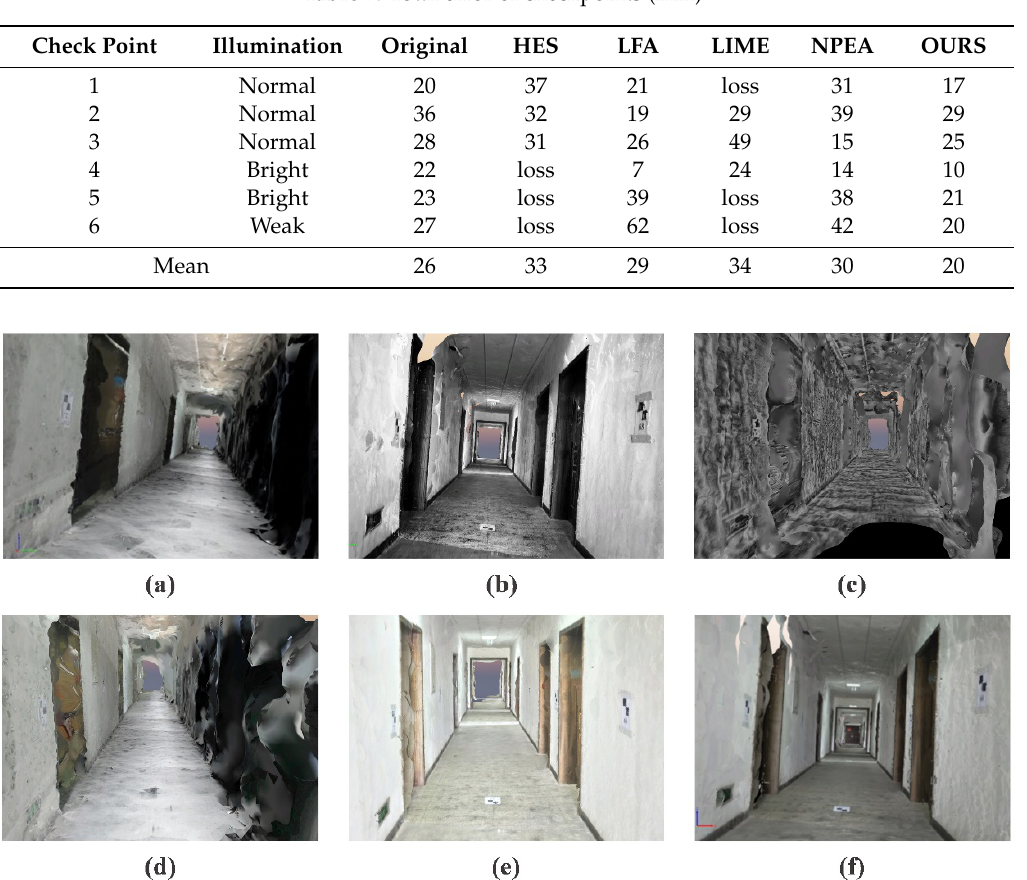
Figure 10. Comparison of the results of MVS with original and optimized images: ( a ) original; ( b ) HES; ( c ) LFA; ( d ) LIME; ( e ) NPEA; and ( f ) our method.